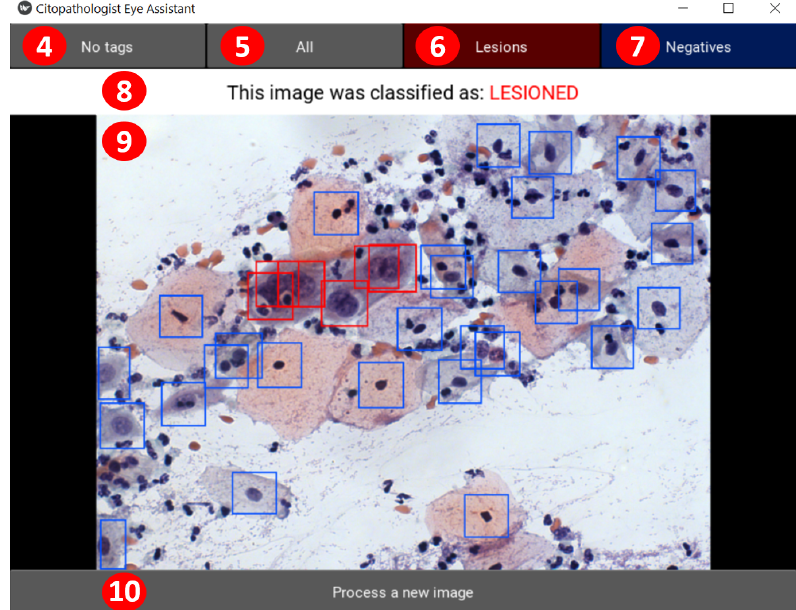
Figure 6. CEA evaluation